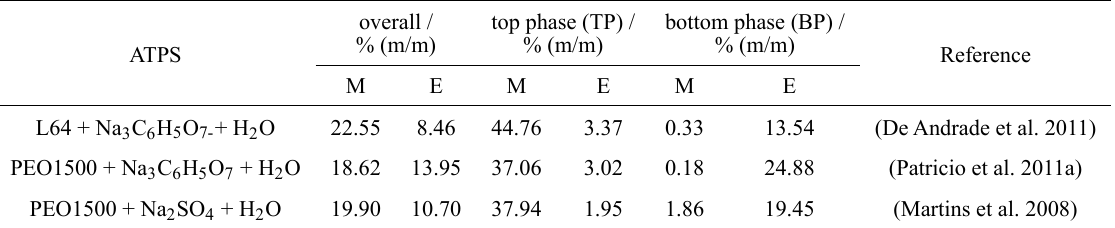
Concentration of components in the